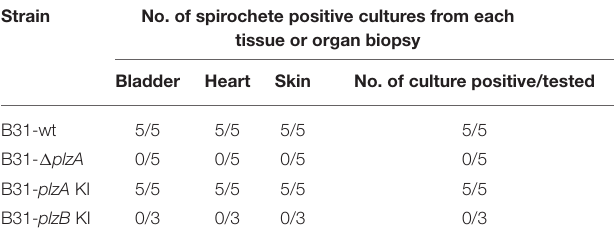
TABLE 3 | Murine infection study.